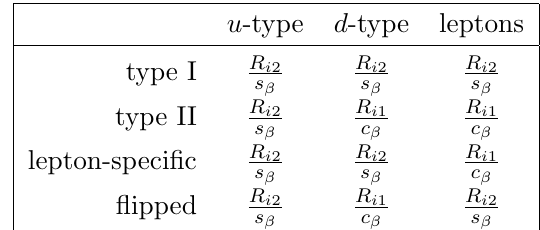
Table 2 . The four Yukawa types of the Z 2 -symmetric 2HDM de(cid:12)ned by the Higgs doublet that couples to each kind of fermion.